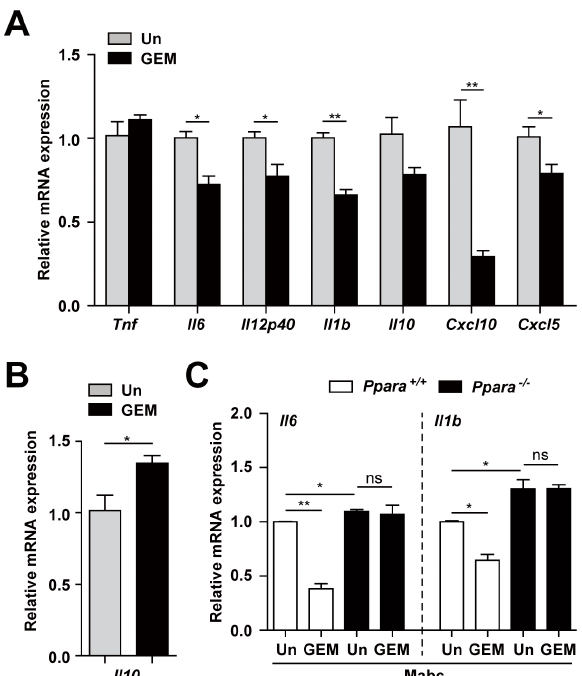
Figure 4. PPAR α activation by GEM regulates the Mabc-mediated expression of inflammatory cytokines in a PPAR α -dependent manner. ( A,B ) BMDMs were infected with Mabc (MOI of 5) and treated with gemfibrozil (GEM; 100 μ M) for 6 (B) or 18 h (A). The mRNA levels of proinflammatory cytokines and chemokines were determined by qRT-PCR. ( C ) Ppara +/+ and Ppara -/- BMDMs were infected with Mabc (MOI of 5) and treated with GEM (100 μ M) for 18 h. The mRNA levels of Il6 and Il1b were measured by qRT-PCR. Data are means ±SD of three independent experiments. * p < 0.05 and ** p < 0.01. Un, untreated; ns, not significant.